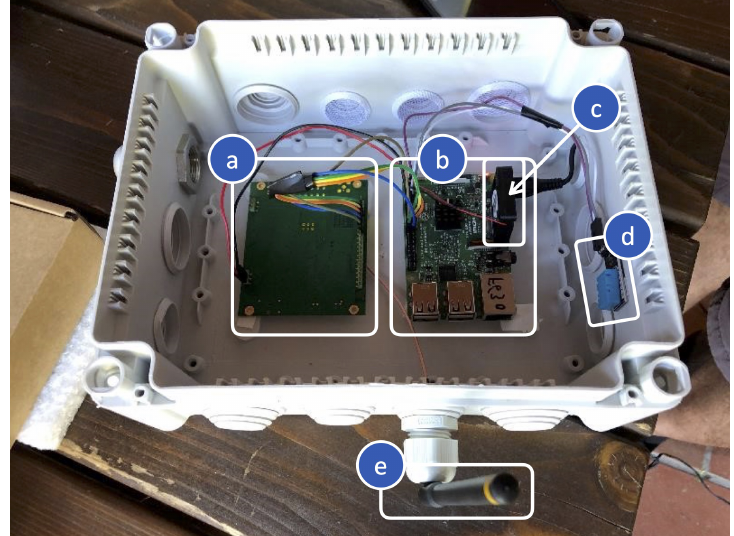
Figure 5. The deployed LoRaWAN GW: ( a ) iC880A-SPI concentrator board; ( b ) RPi; ( c ) the cooling fan; ( d ) the DHT11 air sensor; and ( e ) the 868 MHz